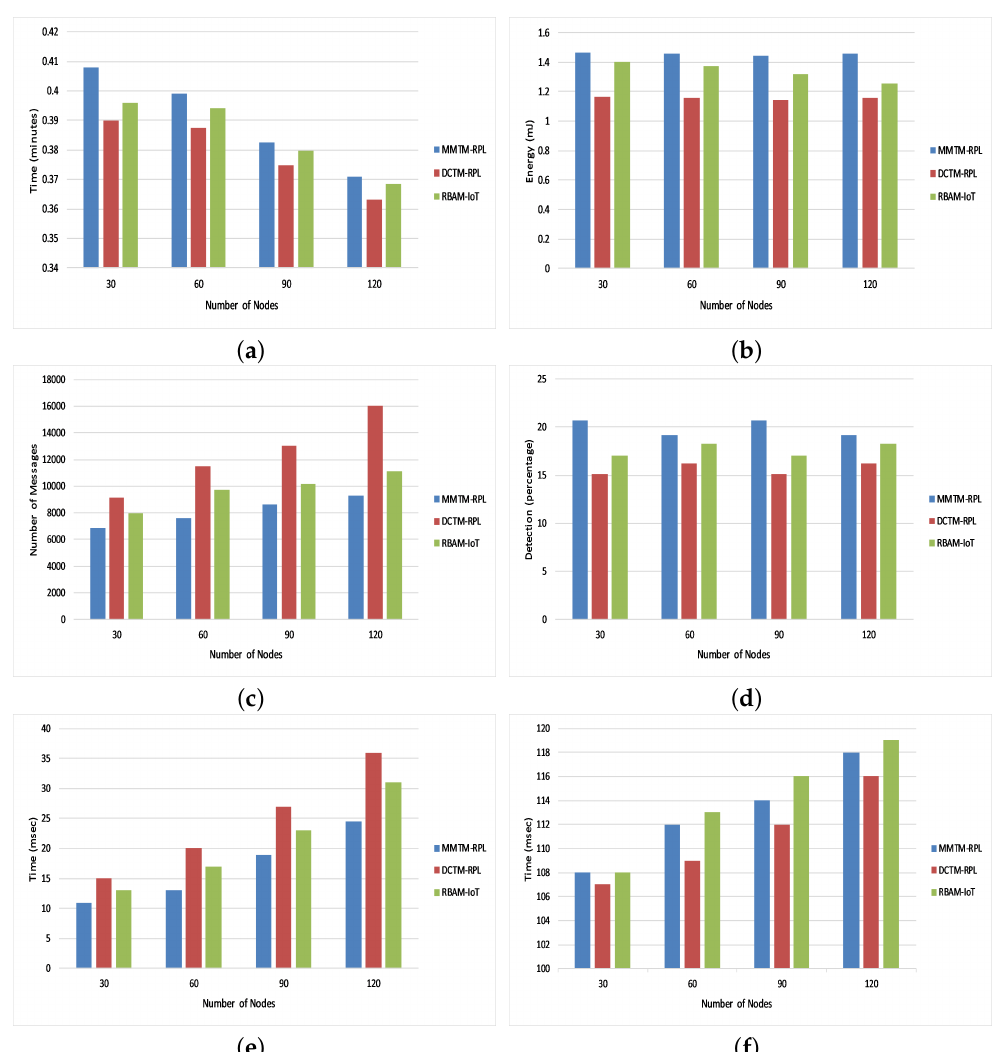
Figure 10. Overview of results for the different frameworks: ( a ) Network lifetime, ( b ) Average residual energy, ( c ) Control message overhead, ( d ) Attack detection rate, ( e ) Attack detection time, ( f ) End-to-end